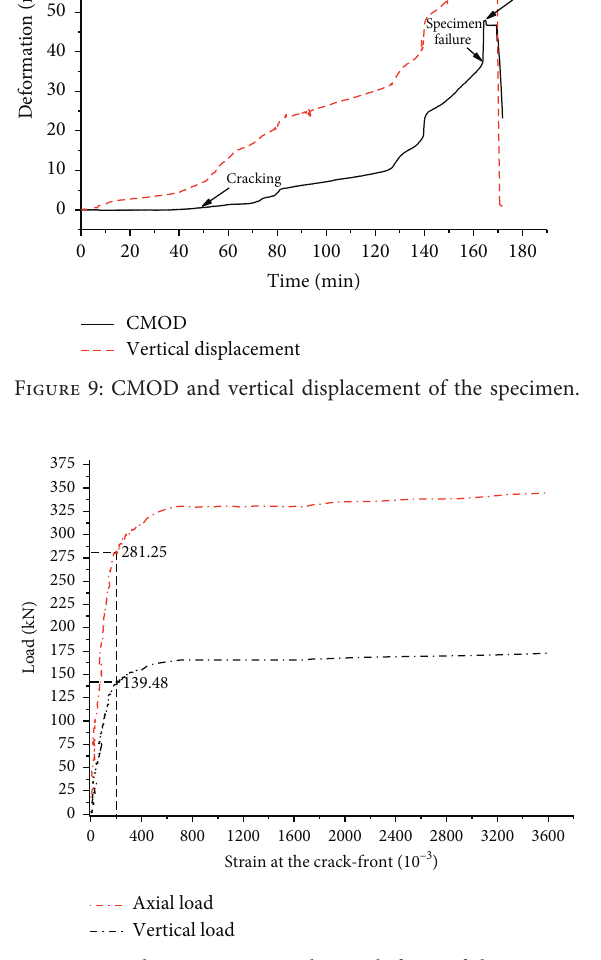
Figure 10: Load versus strain at the crack-front of the Table 1: The cracking loads of the shield segment by the experiment.